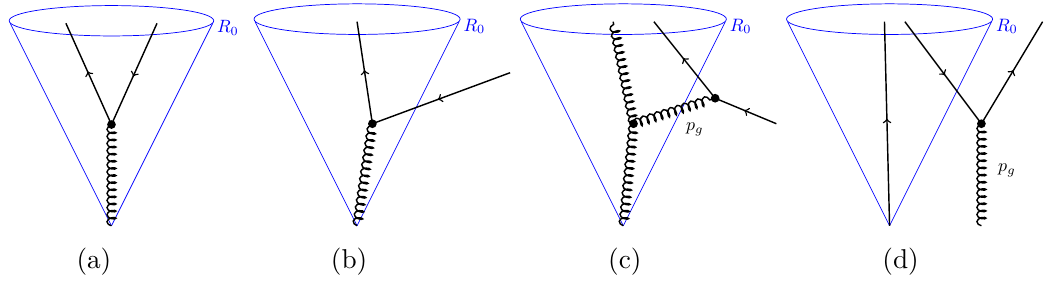
Figure 5 . Examples for partonic input configurations to the flavour assignment algorithm. Con- figuration (a) needs to be identified as a gluon jet in the collinear limit, whereas for (b) we need to perform the LL resummation for a quark jet. IR safety requires that configurations (c) and (d) in the limit where p g → 0 are identified as gluon and quark jet,